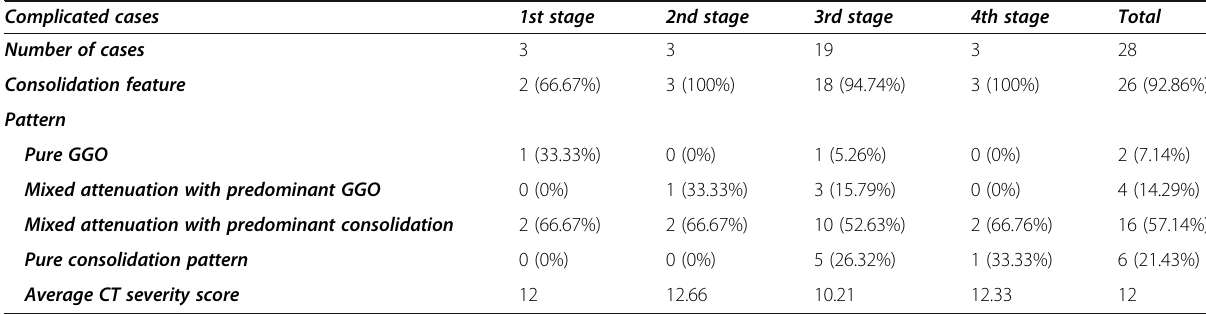
Table 3 The incidence of consolidation and different CT patterns in complicated cases during different stages of the disease Complicated